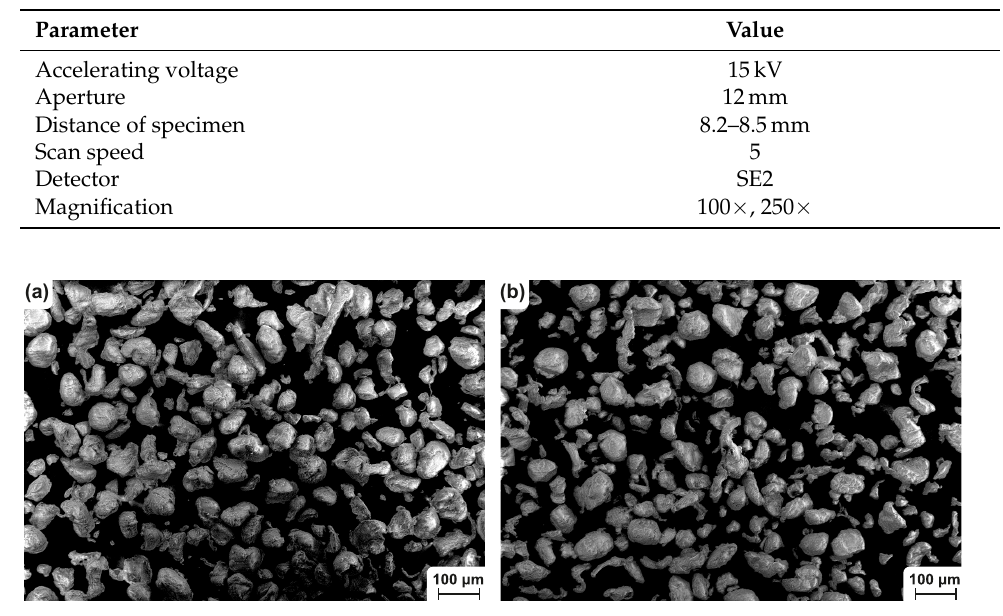
Table 2. Parameters of SEM analysis for PP powder morphology analysis.